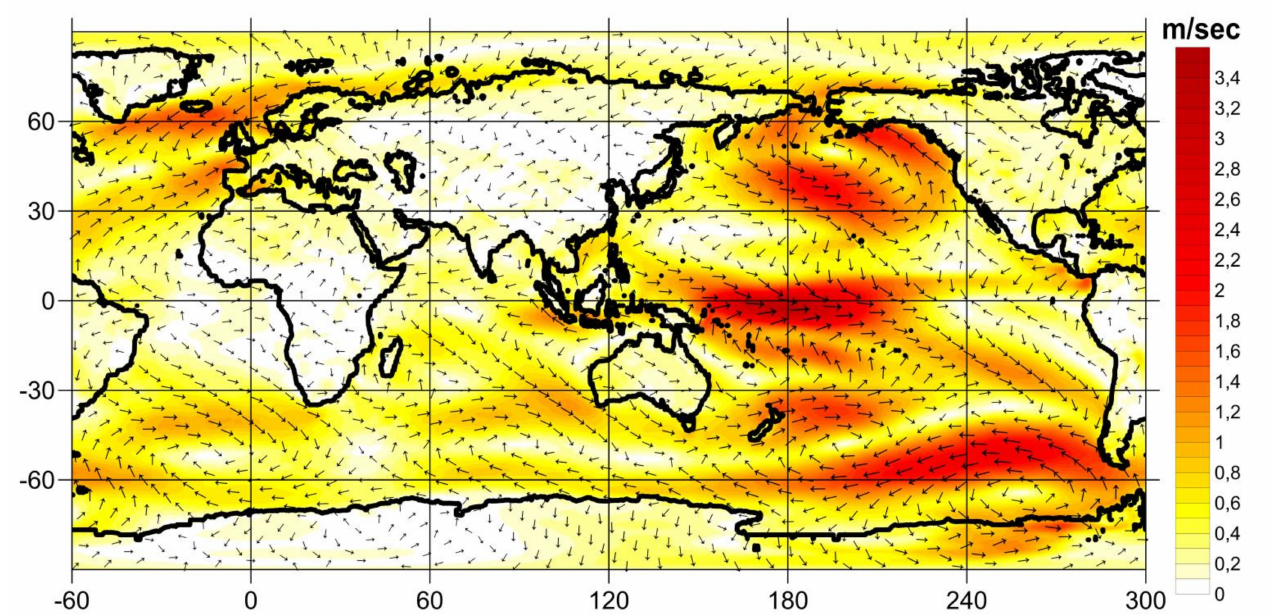
Figure 5. The difference in average wind speed anomalies at a height of 10 m from the surface between opposite phases of the Global Atmospheric Oscillation by GAO2